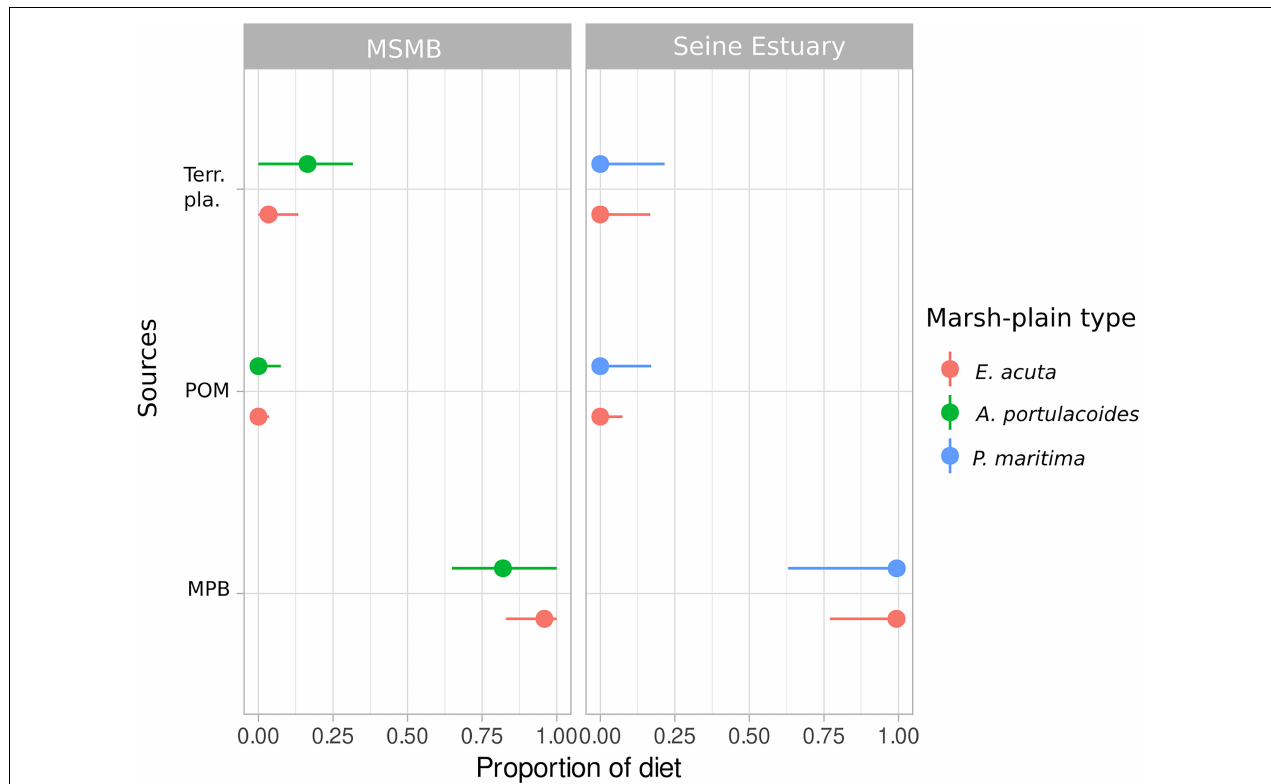
FIGURE 5 | Posterior median (points) with 90% (horizontal lines) confidence intervals for contribution of each primary producer (MPB, microphytobenthos; POM, particulate organic matter; Terr. pla., terrestrial plants) according to marsh-plain type in the sampling area for Chelon ramada . MSMB, Mont-Saint-Michel